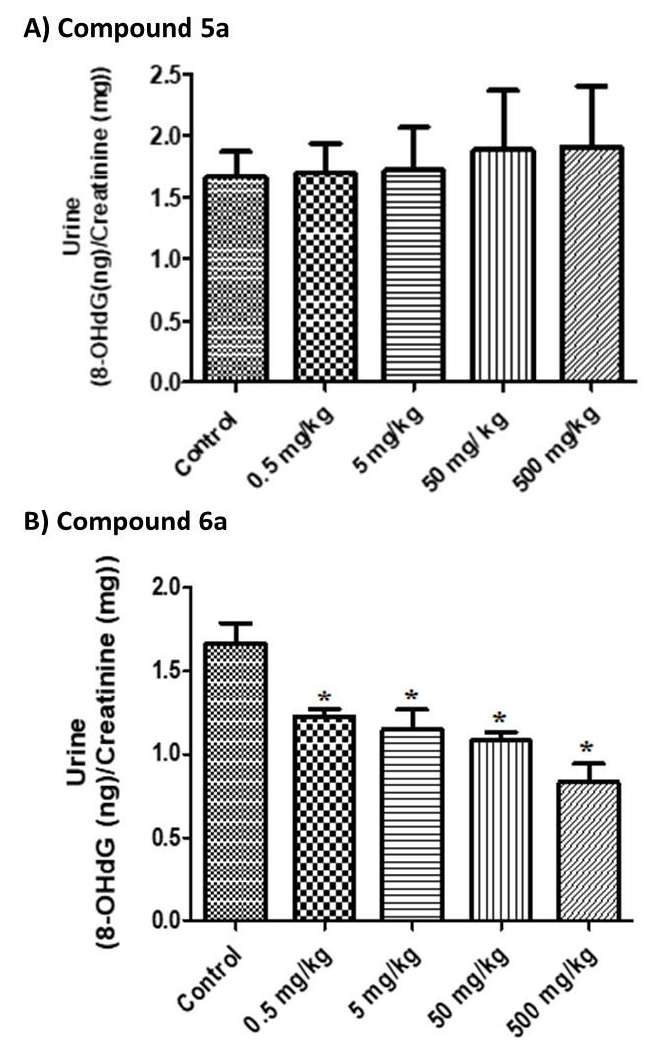
Figure 1. The genotoxicity of the ( A ) 1,2,3-thiadiazole ( 5a ) and ( B ) selenadiazole ( 6a ) compounds; * significant di ff erence from control at p < 0.05 using one-way ANOVA and Tukey’s post hoc